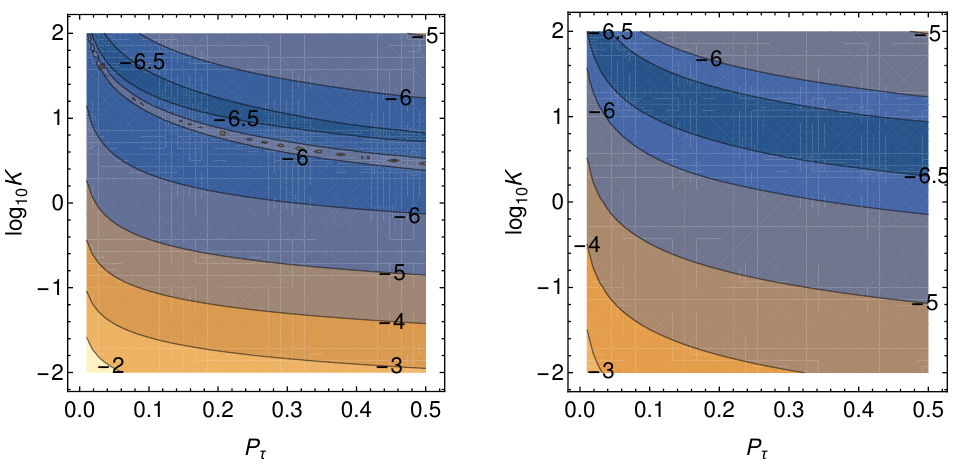
Figure 4 . Required log ( (cid:31) j (cid:15) (cid:28) j ) with small CP (cid:22)(cid:28) breaking (cid:31) = 0 : 1 to explain the observed baryon 10 asymmetry with zero (left) and thermal (right) initial N 1 abundance.